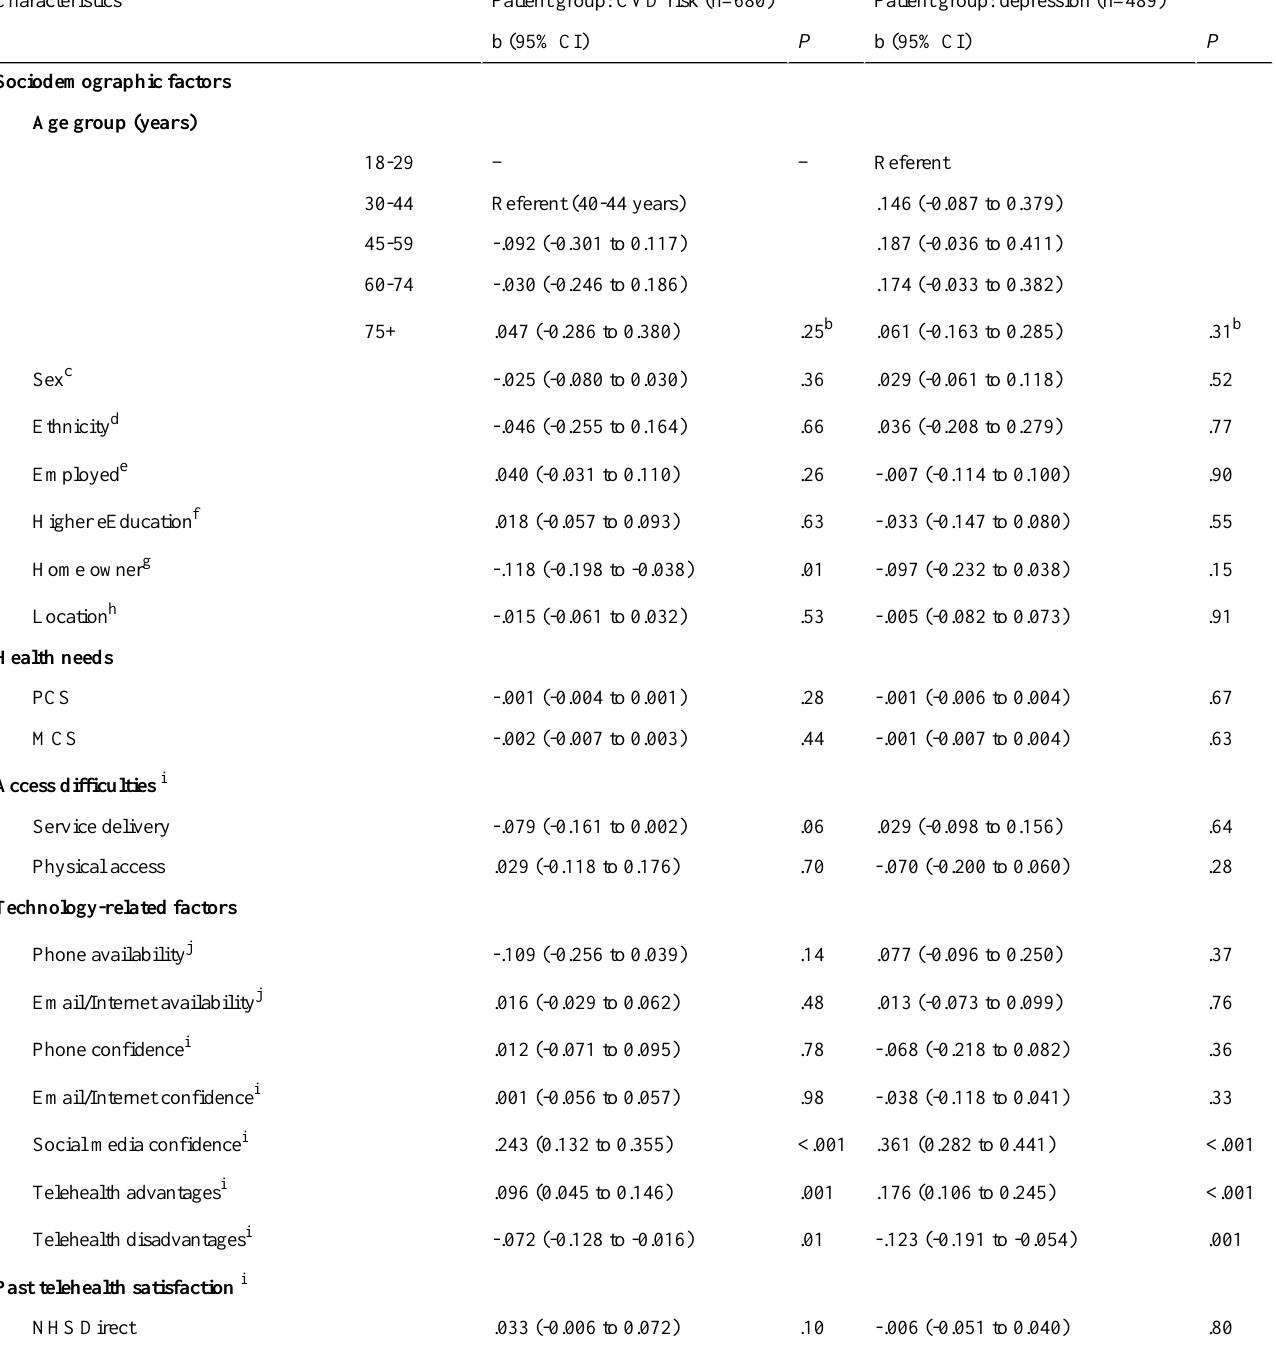
Table 6. Multivariable analysis of factors associated with interest in social media–based telehealth a .